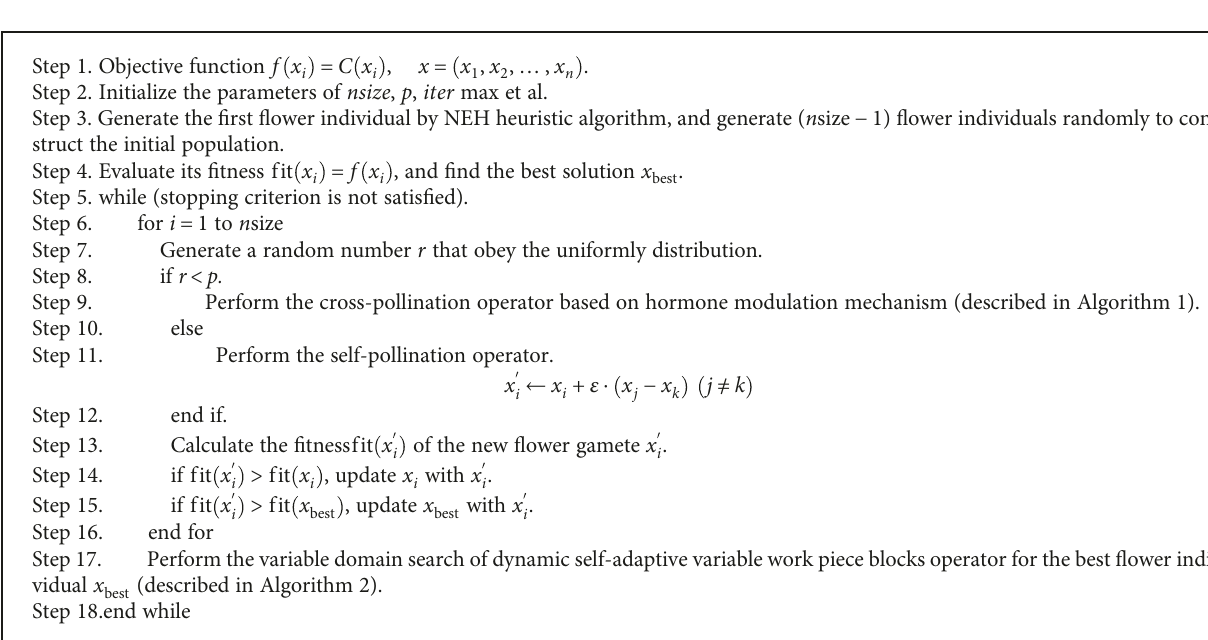
Algorithm 3: The pseudo code of